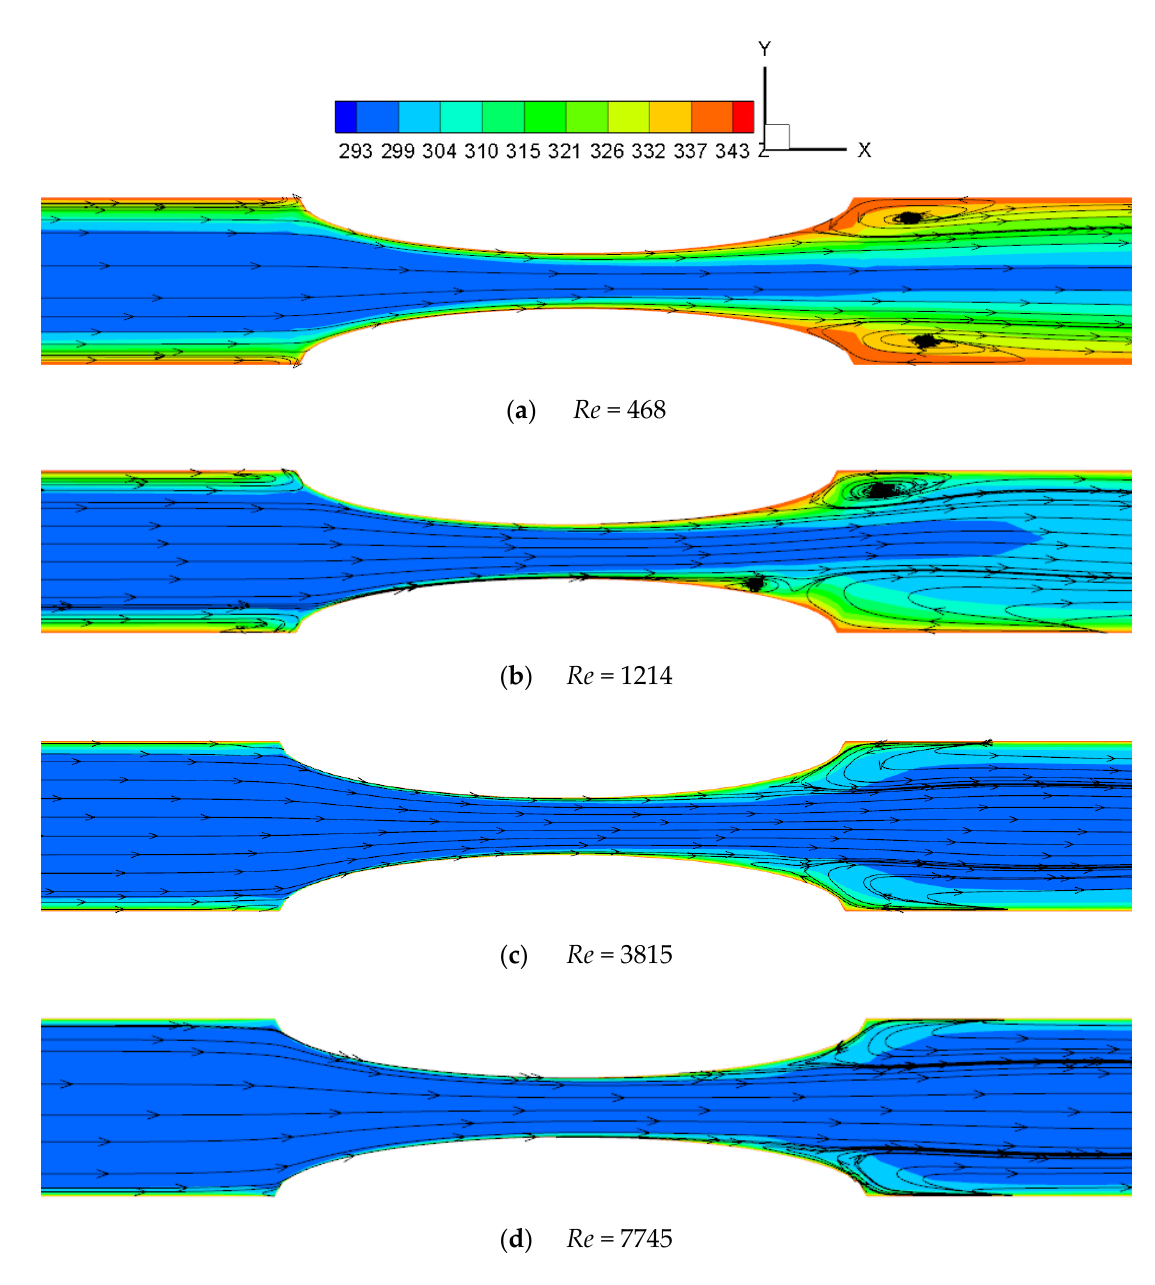
Figure 26. Temperature contours and streamlines on the middle section of protrusion (unit: K).